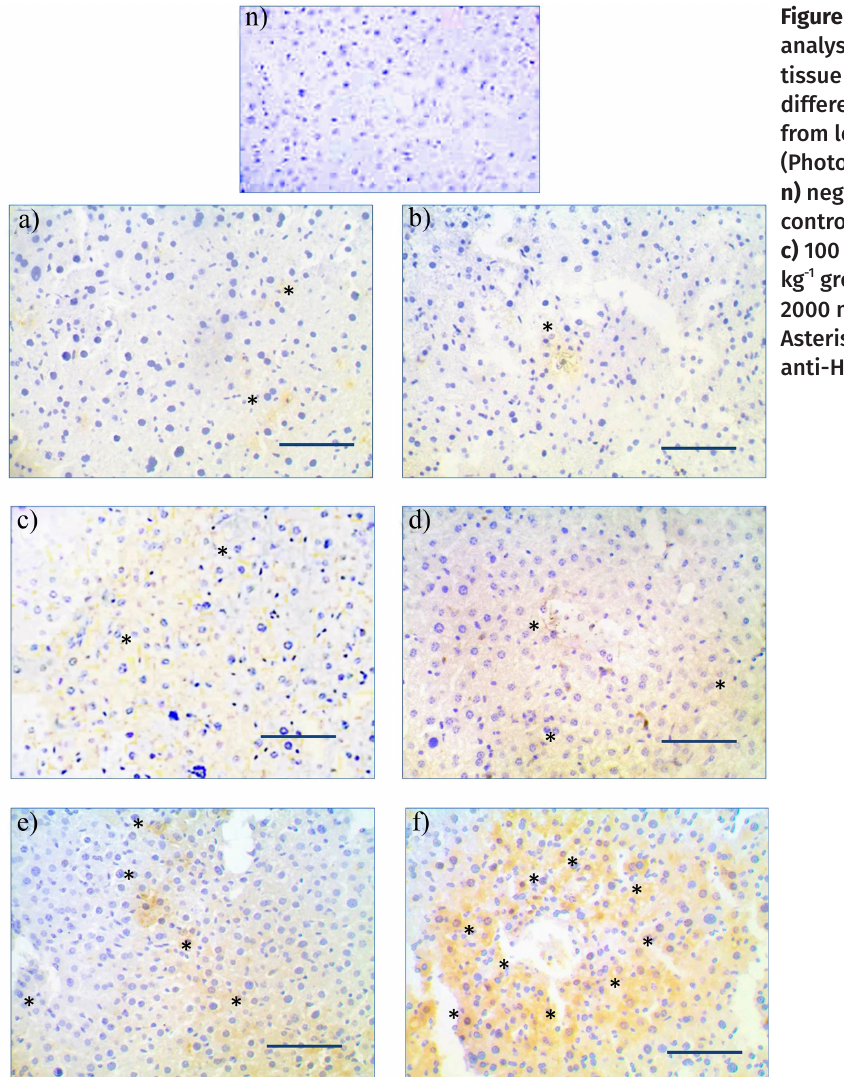
Figure 11. Immunohistochemical analysis of anti-HSP70 in liver tissue of mdx mice treated with different doses of aqueous extract from leaves of Miconia ferruginata (Photomicrography, 1:500 dilution). n) negative control of reaction. a) control group; b) 50 mg kg -1 group; c) 100 mg kg -1 group; d) 200 mg kg -1 group; e) 300 mg kg -1 group; f) 2000 mg kg -1 group. Bar: 400 µm. Asterisks indicate expression of anti-HSP70